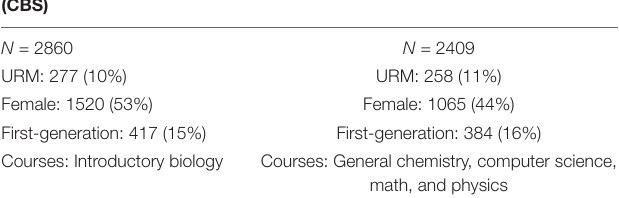
TABLE 2 | A descriptive demographic summary of students sampled from across the College of Biological Sciences (CBS) and the College of Science and Engineering